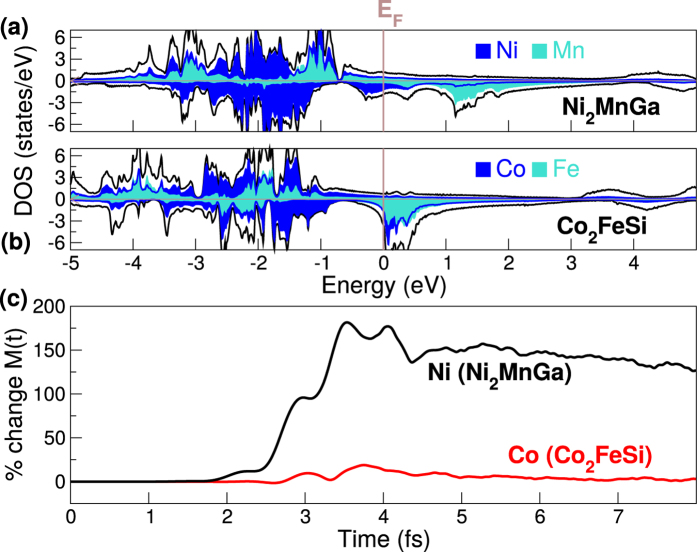
The spin resolved density of states for (a) Ni2MnGa and (b) Co2FeSi, the contribution of the Ni, Co and Mn d-states are given by the filled area. (c) The percentage change of the relative local moment of Ni for the compound Ni2MnGa and Co in the compound Co2FeSi.